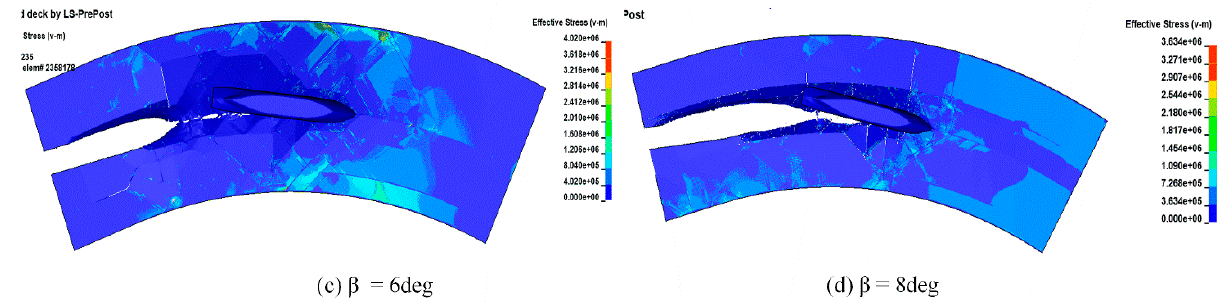
Figure 22. Comparison of ice breaking under different drift angles (3.5 L).